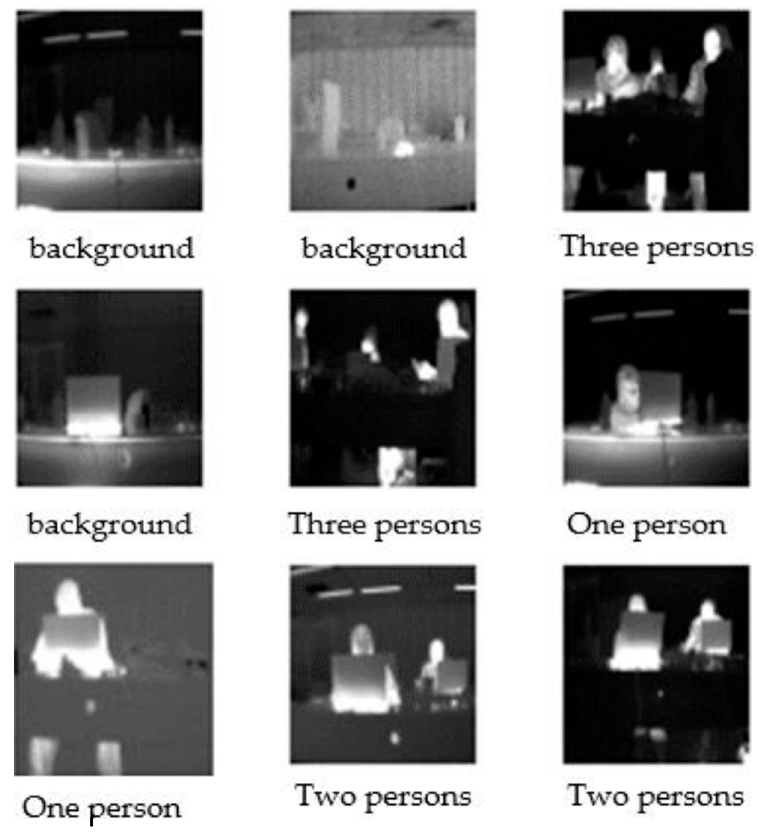
Figure 4. Sample thermal image in each of the four